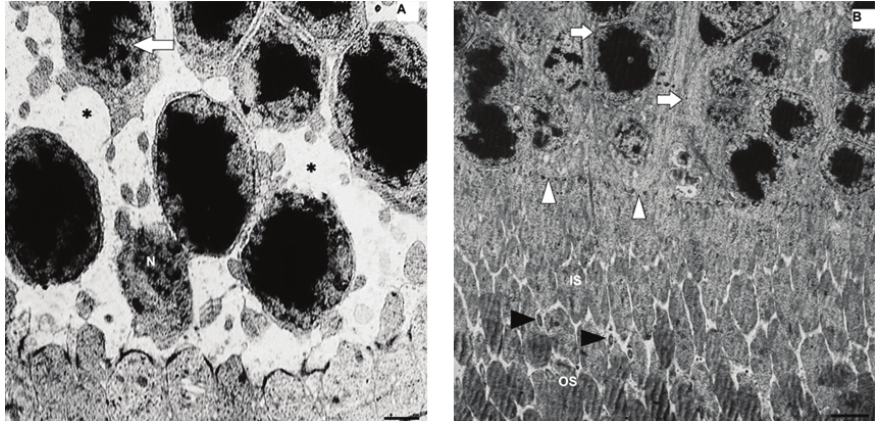
Figure 3. Electron micrographs of the outer nuclear layer (ONL) in group D (A) and group DG (B). (A) Enlarged intercellular spaces (asterisks); nuclear degeneration (N); cytoplasmic and nuclear vacuolization (arrow). (B) Most of the cells showed normal ultrastructure with normal cellular attachments (arrows) forming the intact external limiting membrane (white arrowheads); two connecting cilia (black arrowheads); inner segment (IS); outer segment (OS) (Scale bar is 1 µm in A, 2 µm in B).